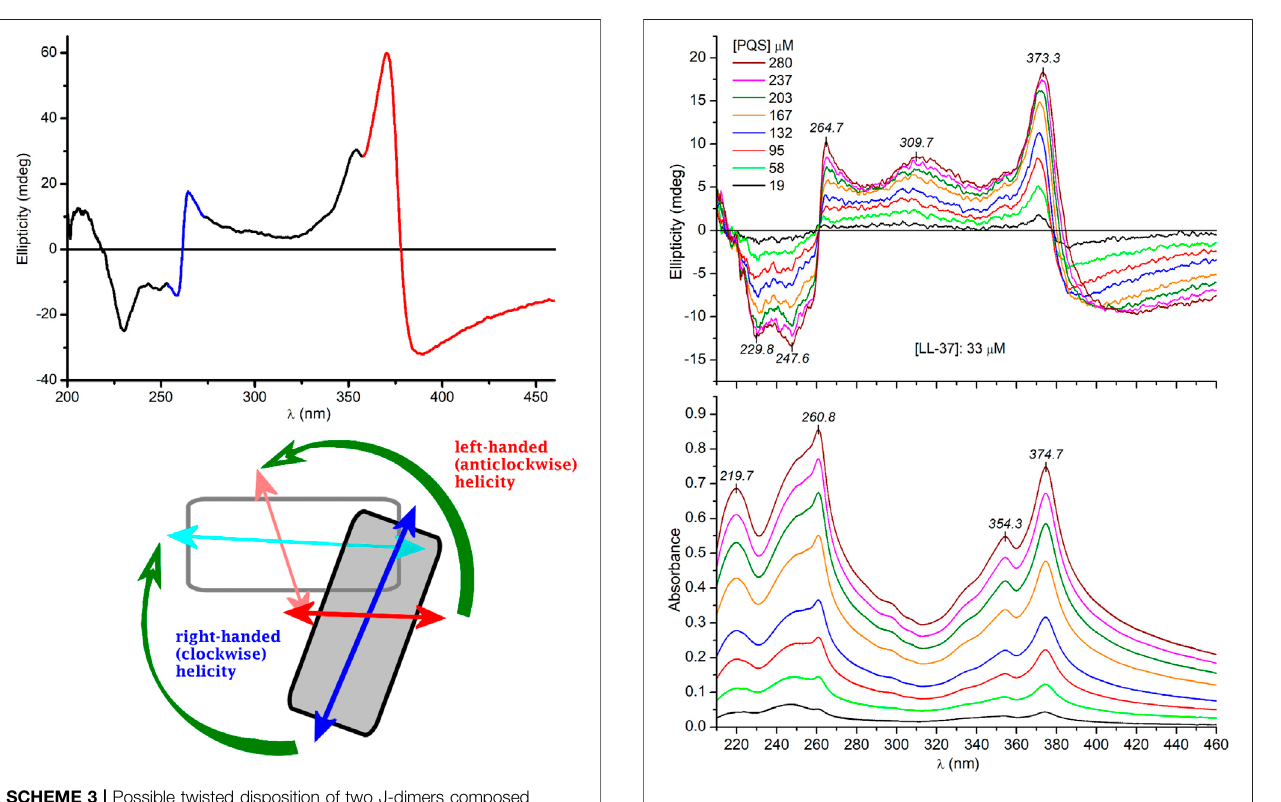
FIGURE 5 | Representative CD and UV/VIS absorption spectra recordeduponaconsecutiveincreaseofPQSconcentrationinTris-HClbuffer solution of 33 μ M LL-37 (the optical path length is 0.2